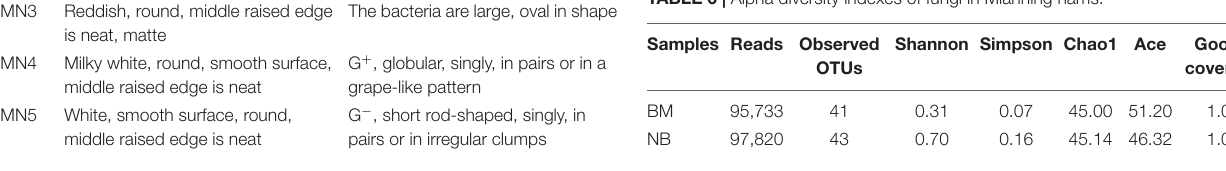
TABLE 6 | Alpha diversity indexes of fungi in Mianning